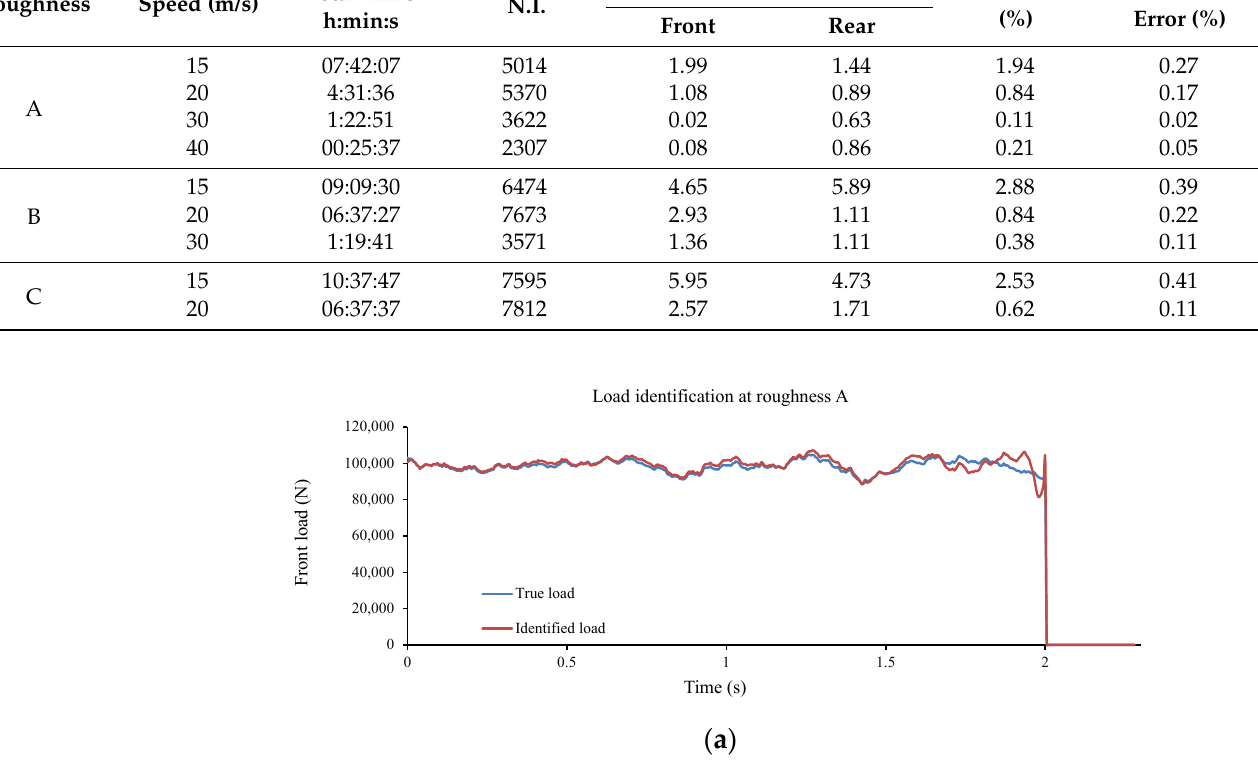
11 of 27 Table 6. The results obtained from different sensor placements.